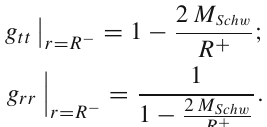
interior stellar geometry is given by the MGD metric